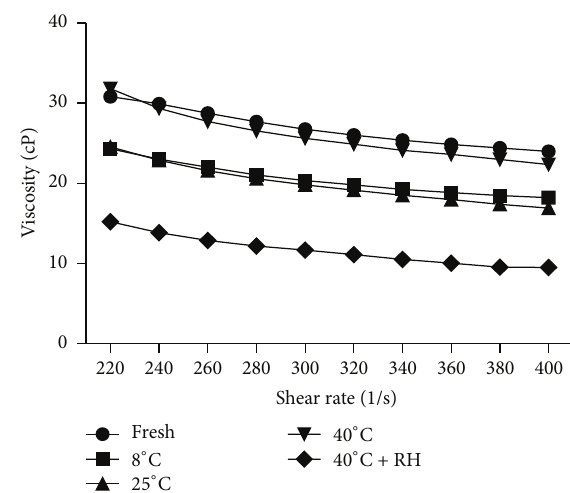
Figure 2: Viscosities of fresh and multiple emulsions kept at different storage conditions on varying shear